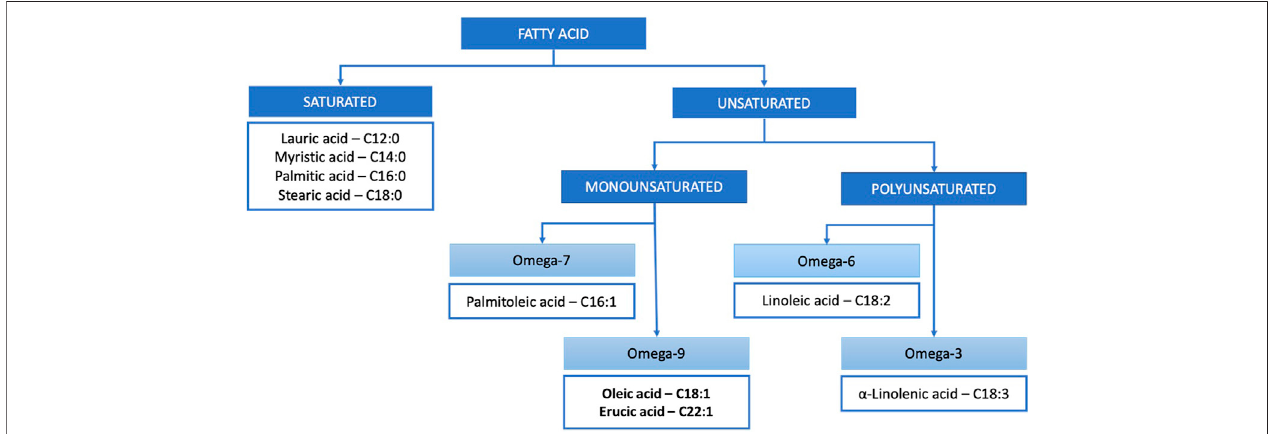
FIGURE 1 | Classi fi cation of the most common fatty acids occurring in vegetable butters and